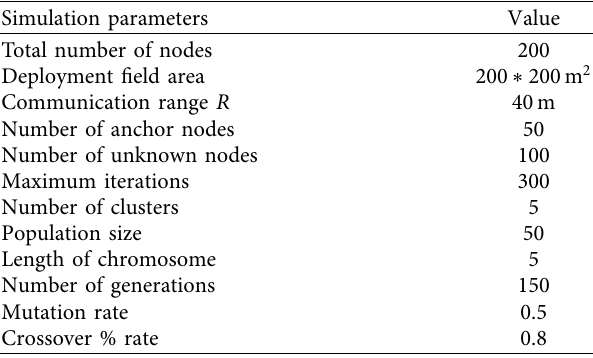
Table 1: Parameters used in sensor field and GA.